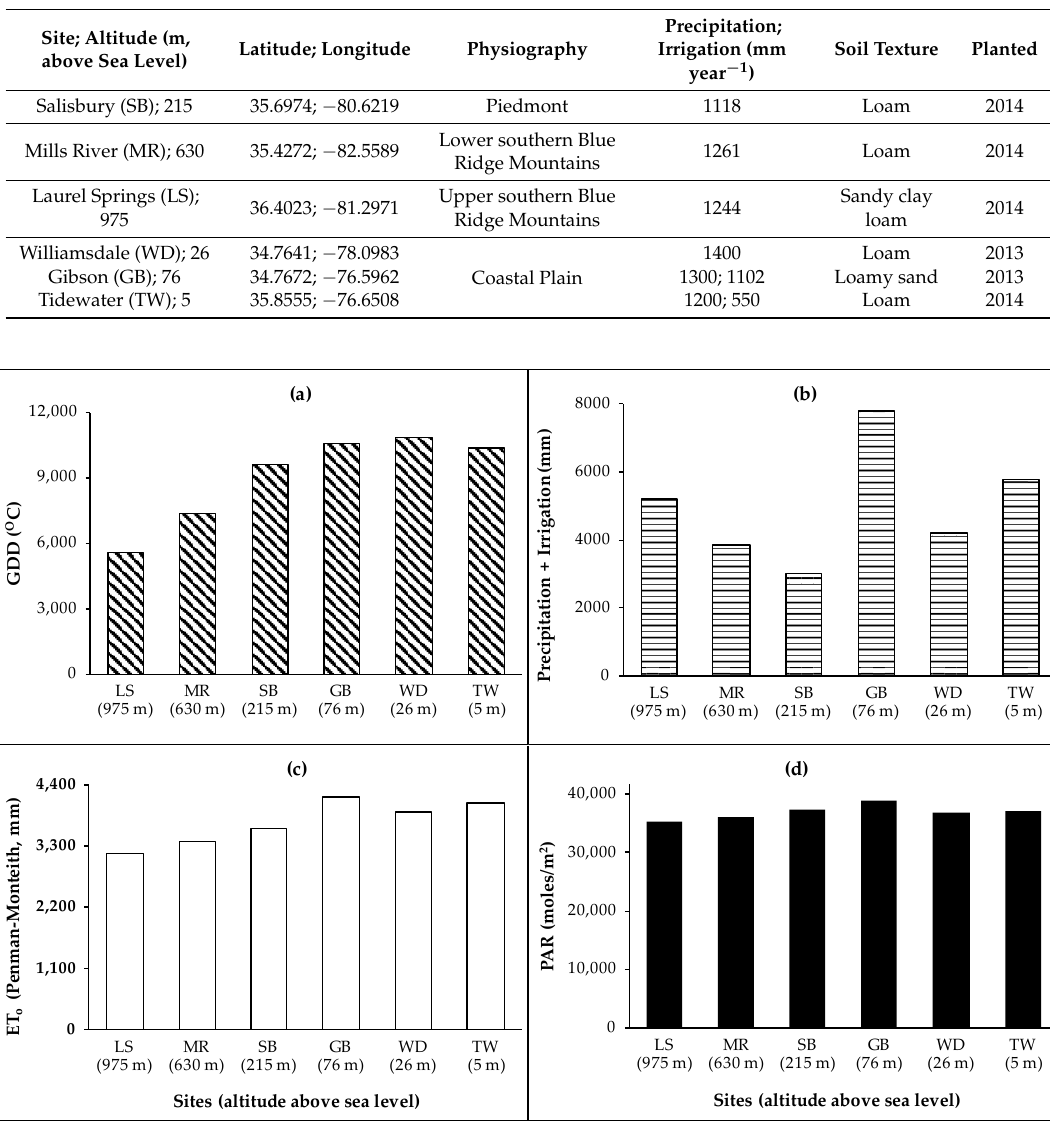
Figure 1. Totals of ( a ) growing degree days (GDD) based on a base temperature of 10 °C, ( b ) precipitation and irrigation, ( c ) Penman–Montheith reference evapotranspiration, and ( d ) photosynthetically active radiation (PAR) at the sites during the 4-year study.